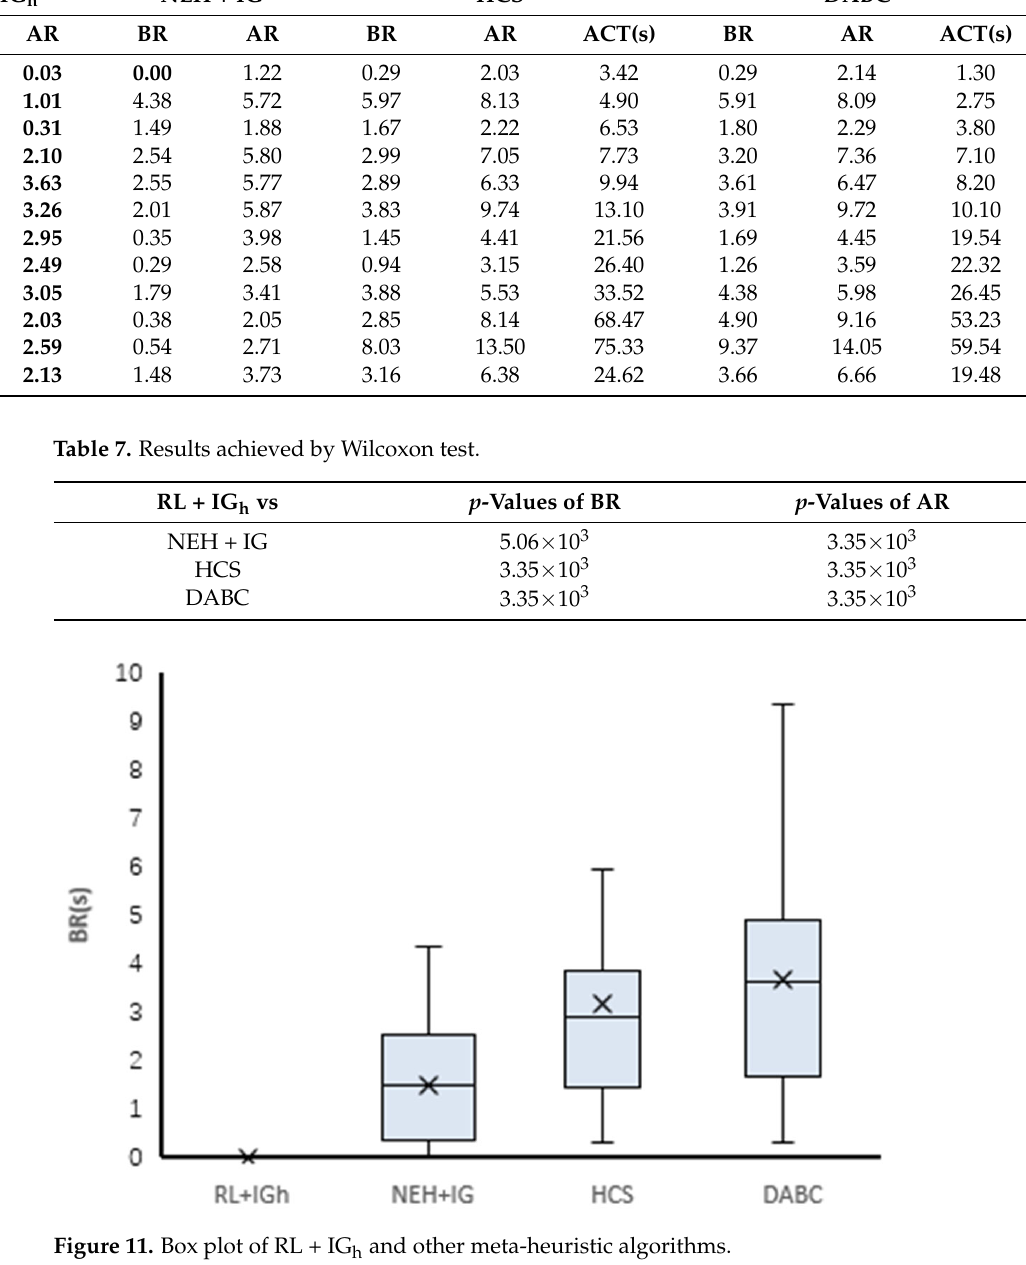
Table 6. Comparison of RL+IG h and multiple meta ‐ heuristic algorithms.